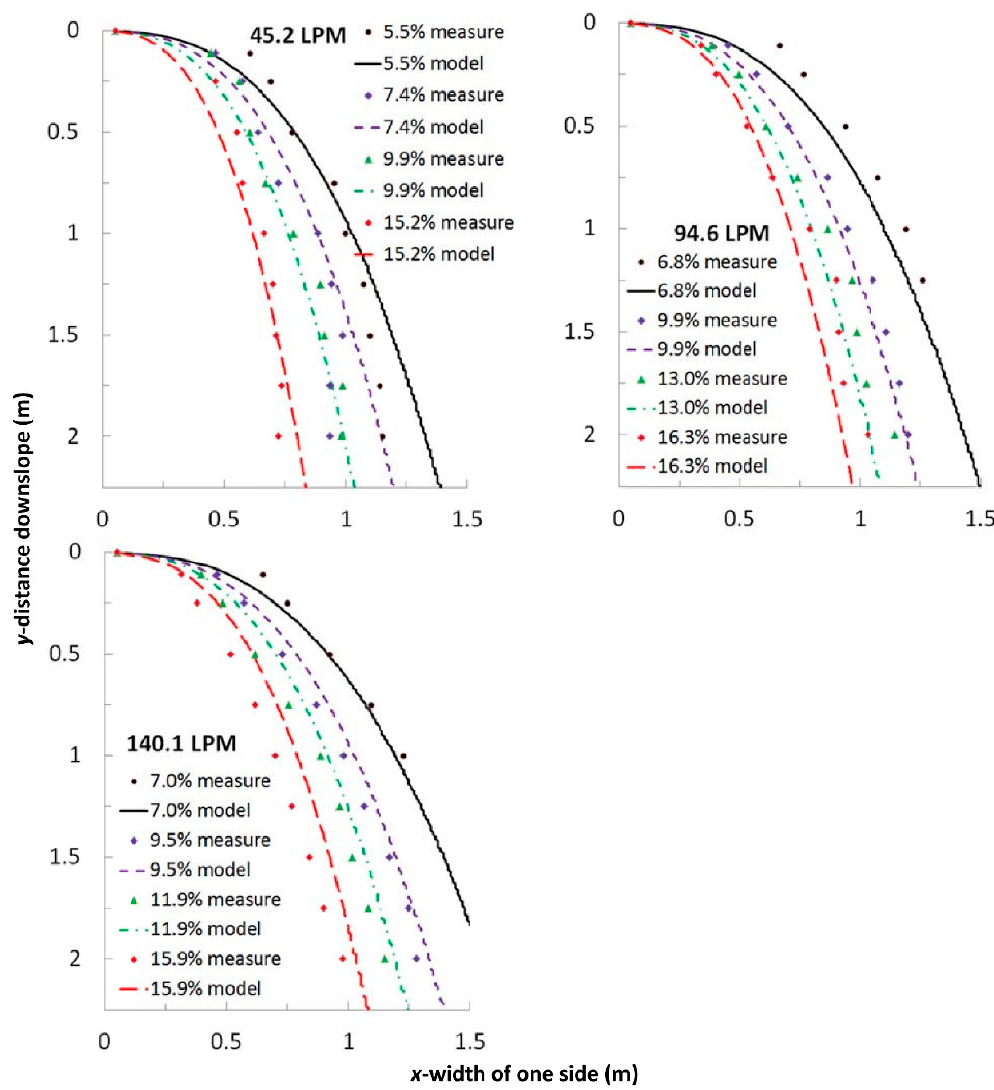
Figure 6. Measured and modeled results of one-side of the water spreading onto a coarse bladed artificial turf for varying Q and S y with x 0 = 10.2 cm. The measured x values are the average of the right and left sides at that value of y . Table 2. Summary statistics of results from measured and modeled testing.